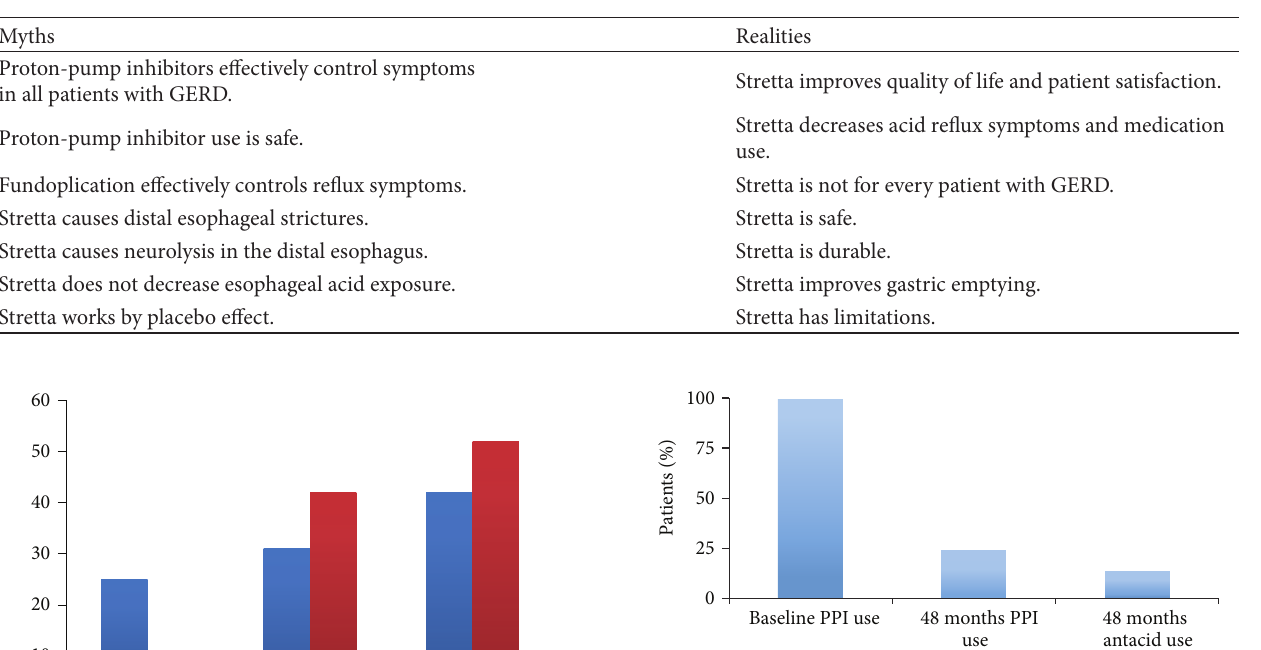
Table 2: Summary of myths and realities concerning GERD treatment.